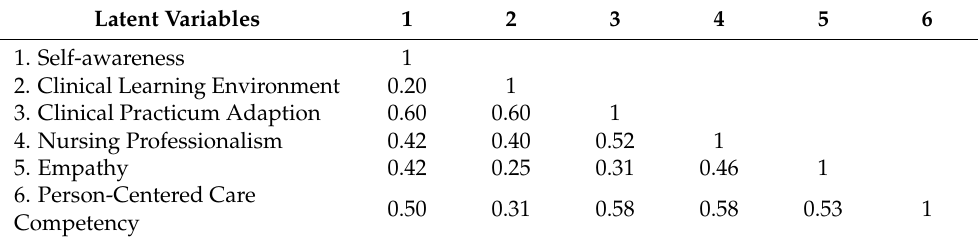
Table 4. Correlations between variables.